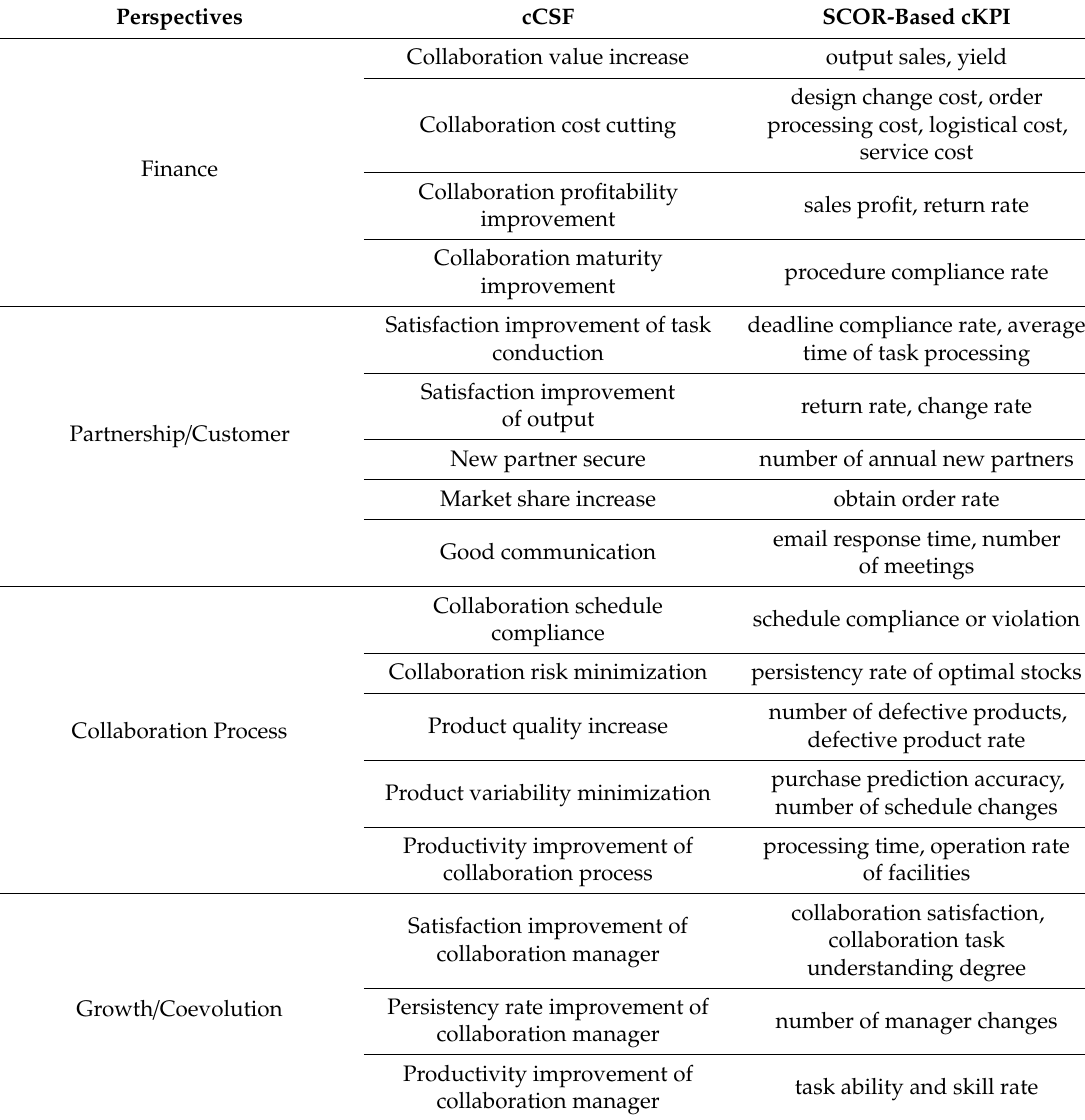
Table 1. Collaborative Balanced Scorecard (cBSC) with collaborative critical success factors (cCSFs) and SCOR-based collaborative key performance indicators (cKPI) from four new